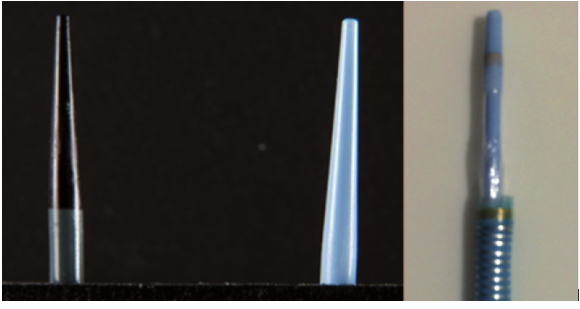
figure 1 - (from left to right) Boston Scientific Navigator HD, Terumo Glideway, and Terumo pathway.